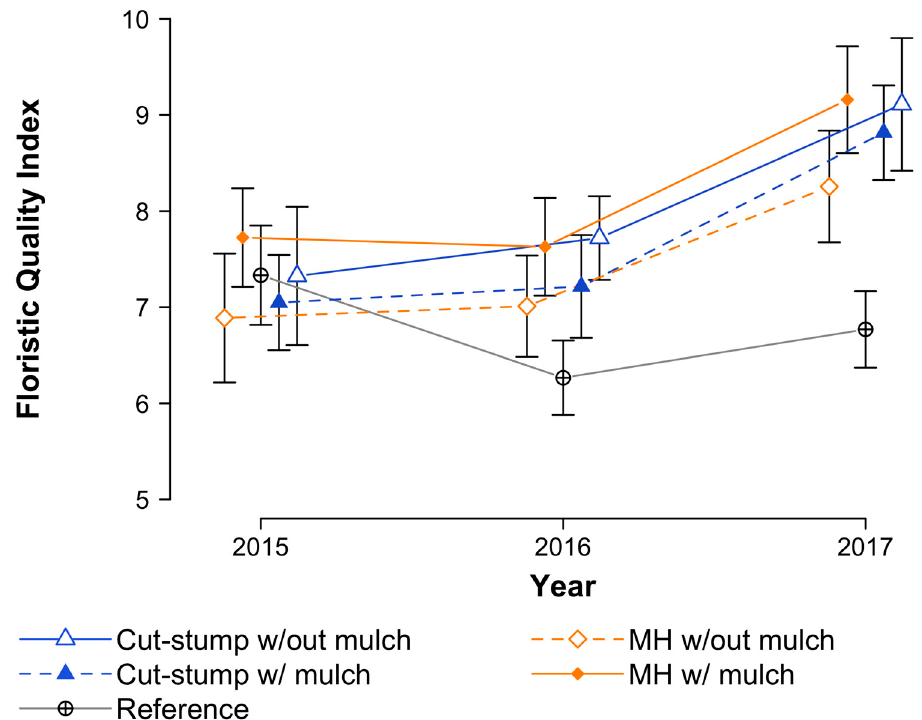
Figure 7. Floristic quality index (FQI) for understory communities, including exotic species, before (2015) and after (2016 and 2017) invasive shrub removal was accomplished using cut-stump or forestry mulching head (“MH”) treatments, with mulch removed/absent or added/present. Invasive shrubs were not removed in reference areas for comparison. Dashed lines indicate management techniques with mulch manipulated (added/removed) and solid lines represent operational (no mulch manipulation) management techniques. Values are mean FQI ± standard error. Data were collected from four mature secondary hardwood forest sites near West Lafayette, IN, from mid-July to early August each